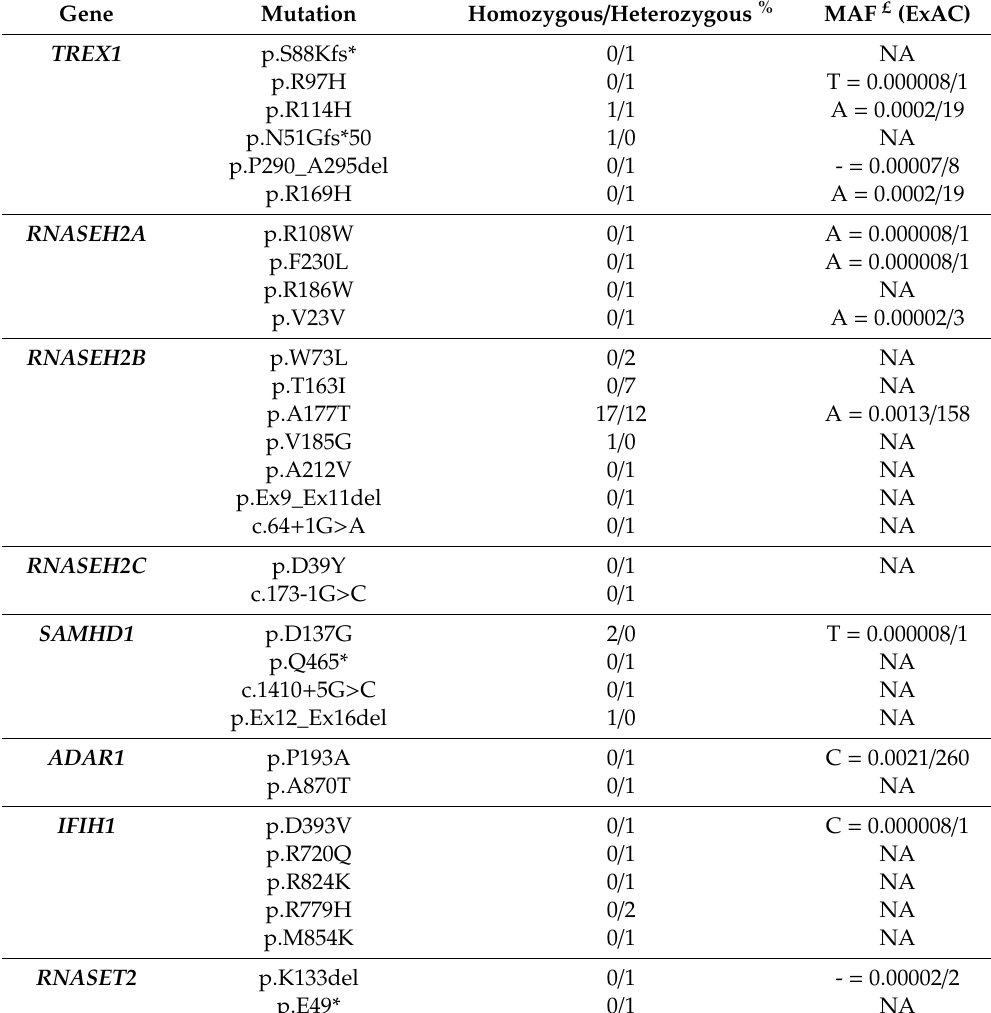
Table 2. Summary of identified